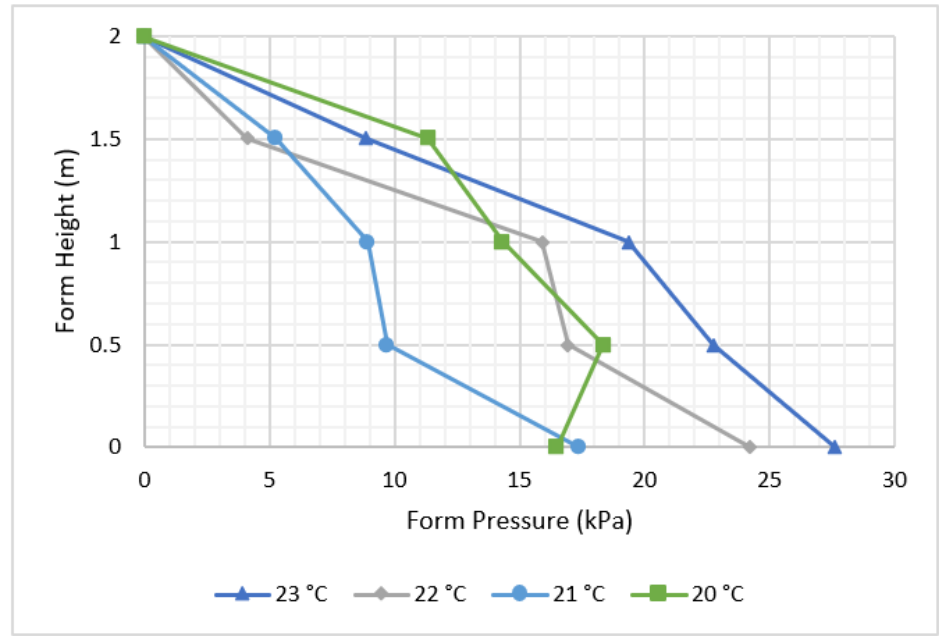
Figure 9. Effect of ambient temperature on form pressure.